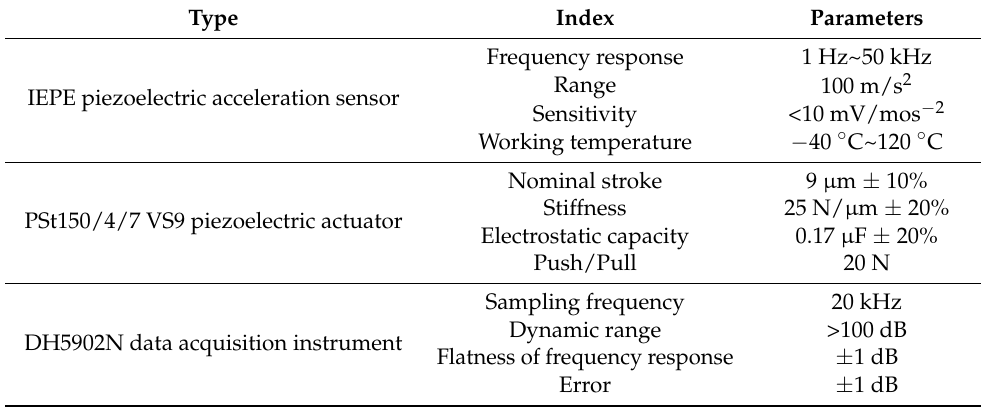
Table 2. The working parameters of the sensor and data acquisition